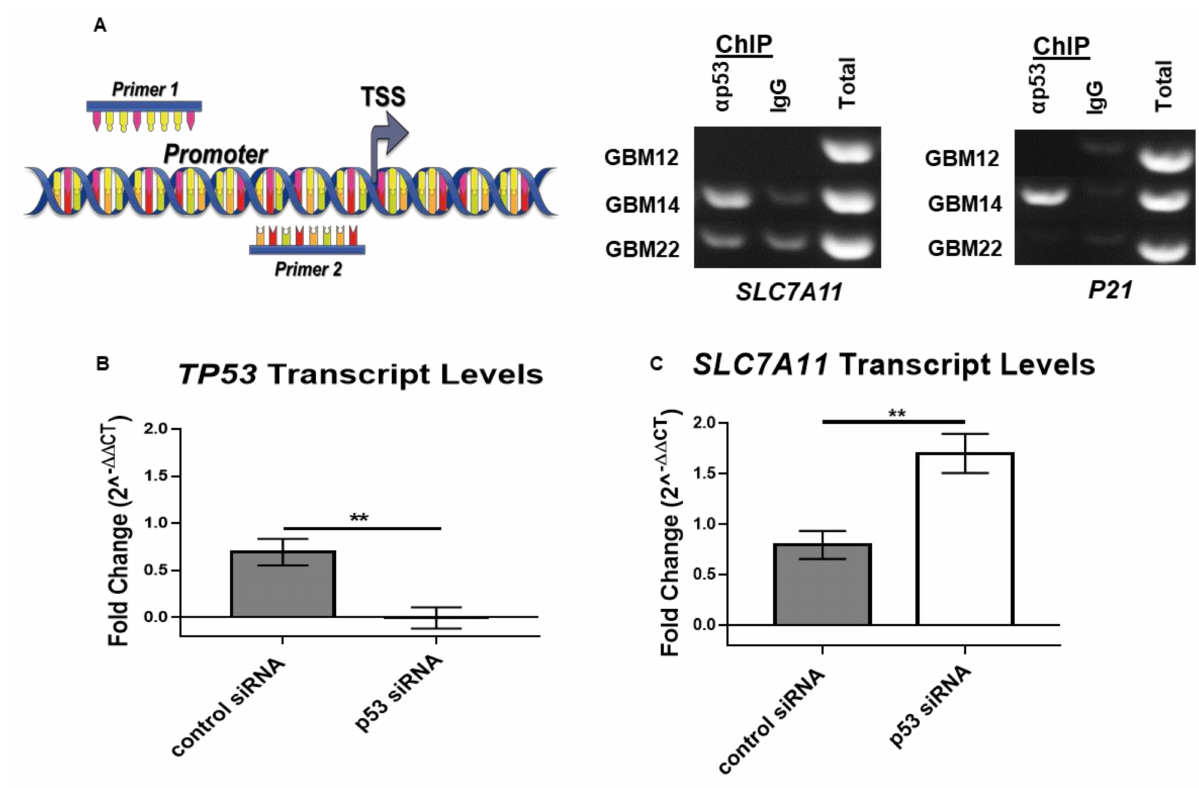
Figure 3. p53 is a molecular switch for xCT expression and function. ( A ) A graphic summary of primer location for ChIP experiments. Gels show amplification of SLC7A11 and P21 after ChIP in three PDX lines. In wild-type p53 tumor cells (GBM14), there is a clear band for SLC7A11 and P21 over the IgG control, unlike in p53-null (GBM12) and mutant (GBM22) lines. Multiple ChIP experiments were performed; this is a representative gel. ( B , C ) All RT-qPCR experiments represent at least three biological replicates. An unpaired two-tailed t-test was performed, and error bars represent the mean ± S.E.M. ** p <